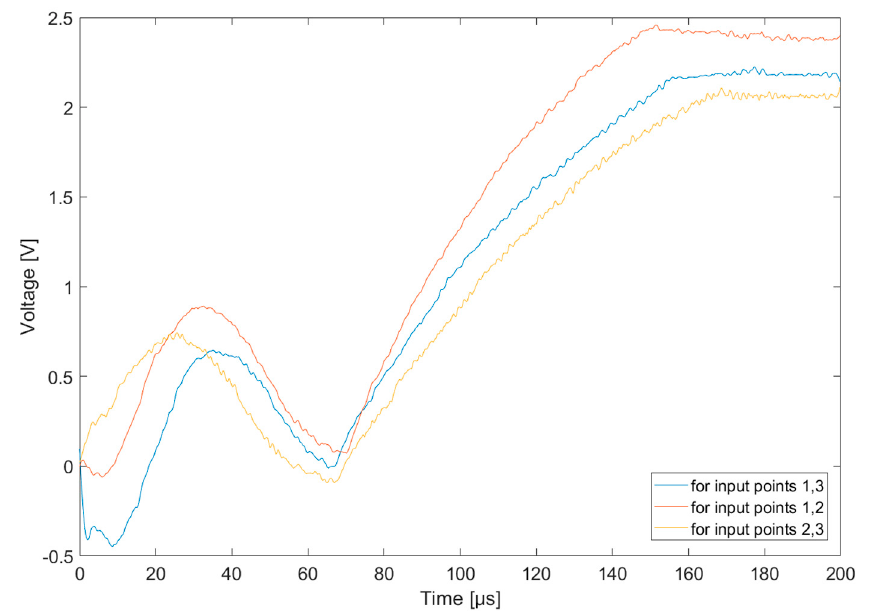
Figure 5. Overvoltage on ESC for surge impulse on all motor coils—input on coil pairs 1 and 2, 2 and 3, 1 and 3. The results were observed in point no. 5.